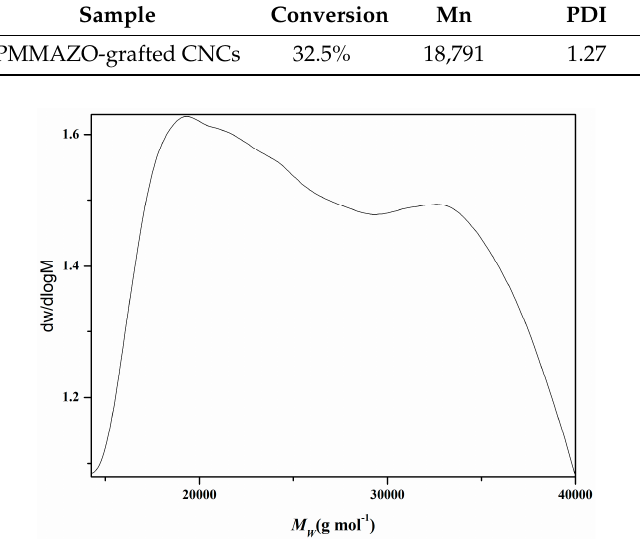
Table 1. Conversion, molecular weights, and polydispersities of grafted polymers during ATRP. Sample